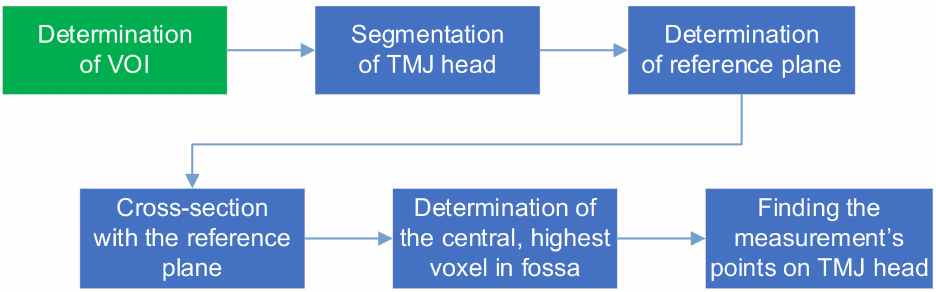
Figure 2. The determination of TMJ parameters